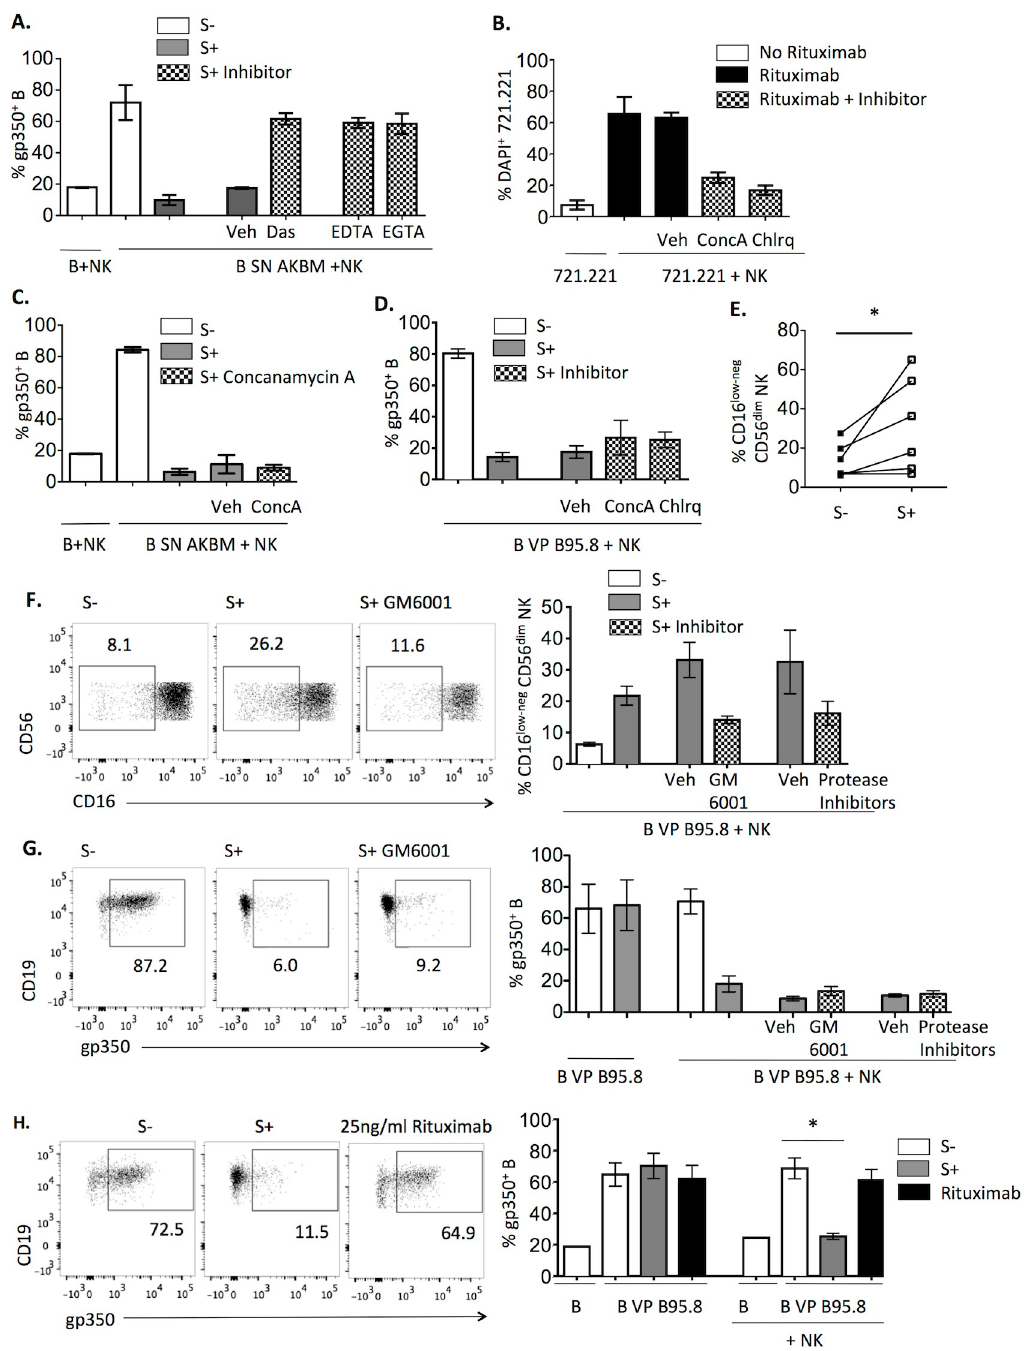
Fig 3. EBV-specific Ab-dependent removal of B cell-bound VP by NK cells is an active process independent of perforin and proteases. (A, C-G) B cells were pretreated with AKBM VP ( A, C, E ) or with B95.8 VP ( D, F, G ), stained after washing with anti-gp350 and cultured with NK cells together with EBV S- or EBV S+ sera for 4h. ( A) NK cells were pre-incubated for 2h with 50nM Dasatinib or vehicle (DMSO), or for 30 min with EDTA (20mM) or EGTA (10mM) and the same concentrations were maintained during the co-culture. The proportions of gp350 + B cells detected in three (Dasatinib, EDTA) or two experiments (EGTA) are shown. ( B-D) NK cells were pre-treated or not for 2h with 1 μ M of Concanamycin A, 50 μ M of Chloroquine or vehicle (DMSO) and co-cultured with 721.221 with or without 100ng/ml of Rituximab ( B ), or with AKBM VP- ( C ) or B95.8 VP-coated ( D ) B cells; the same concentrations of inhibitors were maintained during co-cultures. Proportions of DAPI+ 721.221 cells ( B ) or of gp350 + B cells ( C , D ) from four ( B ) or three experiments ( C , D ) are shown. ( E) Proportions of CD16 low-neg cells detected among CD56 dim NK cells from six experiments are shown. Statistical analysis was performed